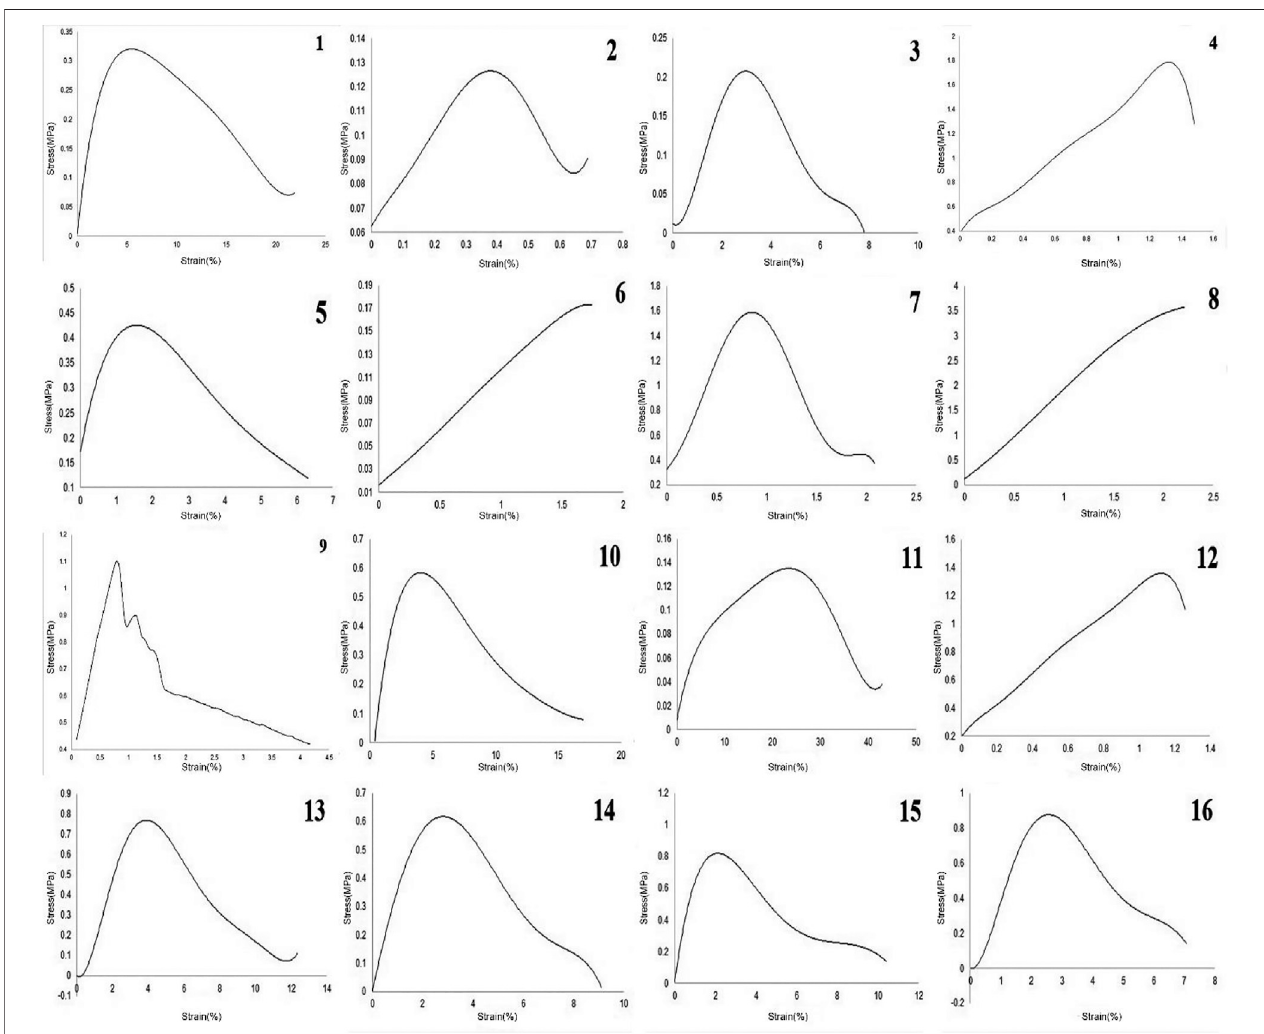
FIGURE 3 | Stress – strain curve of 16 experiments in this